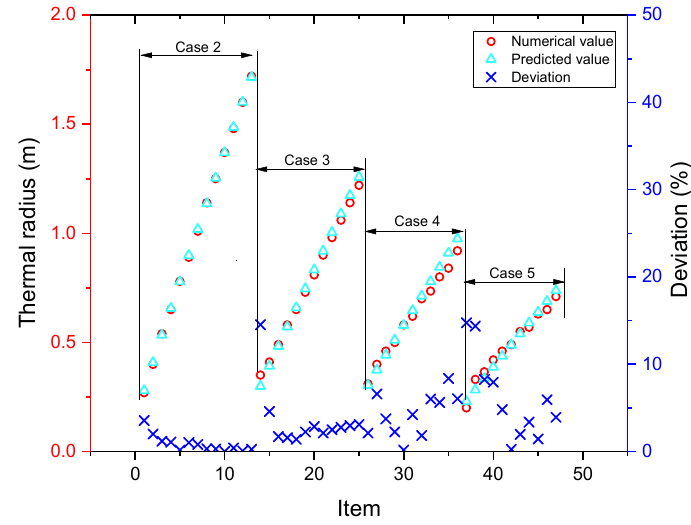
Figure 11. Comparison of simulated and predicted thermal radius.